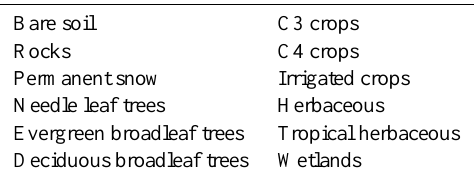
Table 1. Patches used for the description of the nature continental